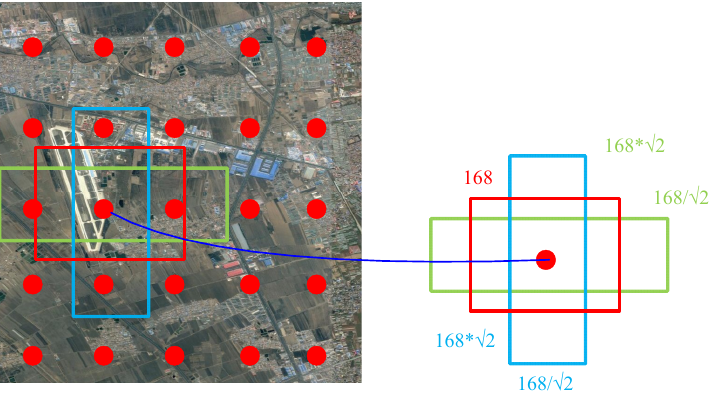
Figure 4. Generation of candidate frames in the network.